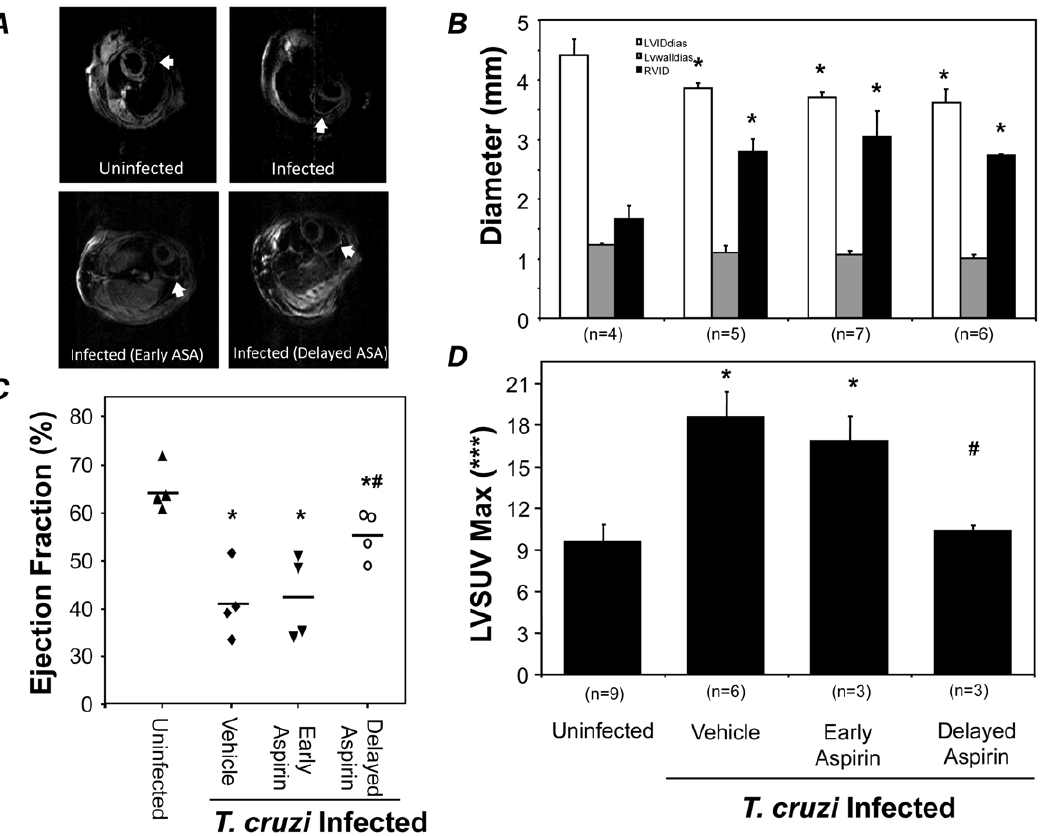
Figure 2. Effects of early and delayed administration of ASA on cardiac structure and function. A . Short axis MRI images showing cardiac remodeling during T. cruzi infection of CD-1 mice with and without ASA treatment (20 mg/kg). Arrows indicate the wall of the right ventricle of the heart. B . Cardiac dimensions were assessed in uninfected and infected with or without ASA at 5 (Early) or 60 (delayed) dpi. Parameters quantified included left ventricular internal diastolic diameter ( B , while squares), left ventricular wall diameter ( B , grey squares), right ventricular internal diameter ( B , black squares). C . Ejection fraction measured using echocardiography. D . Left ventricular glucose SUV measured by microPET. Number of mice in each group is indicted. * and # indicates significance ( P # 0.05) from uninfected and infected mice, respectively.